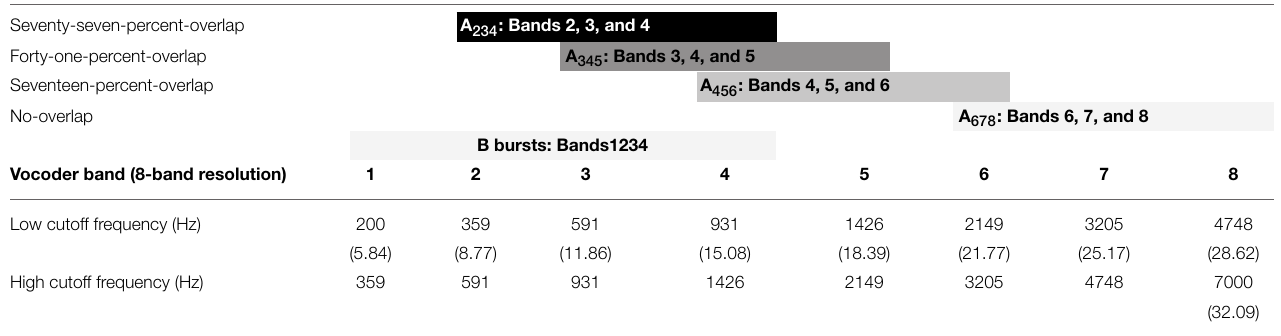
TABLE 1 | Cutoff frequencies of the A and B bands at four spectral conditions and the relationship of the A and B bands with the eight vocoder bands from Fu and Nogaki (2005).